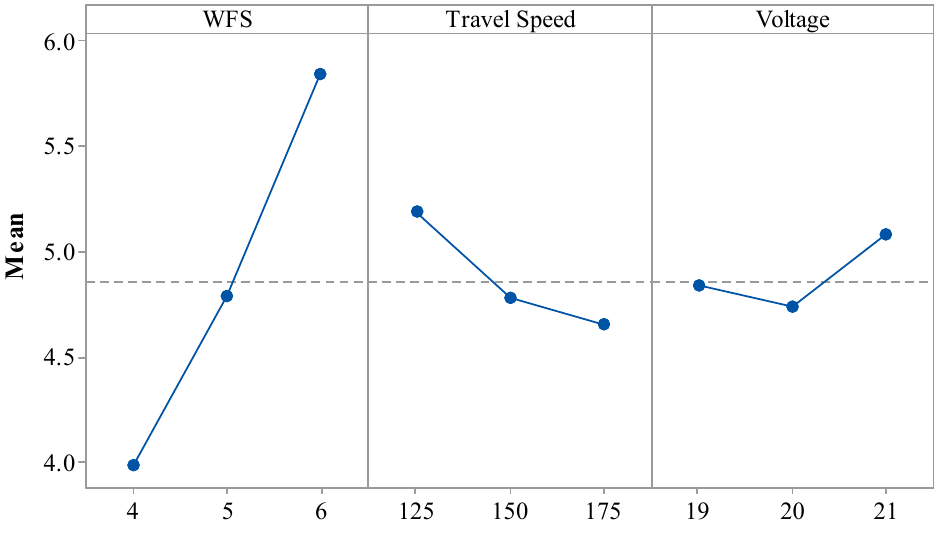
Figure 8. Main effect plot for bead height.